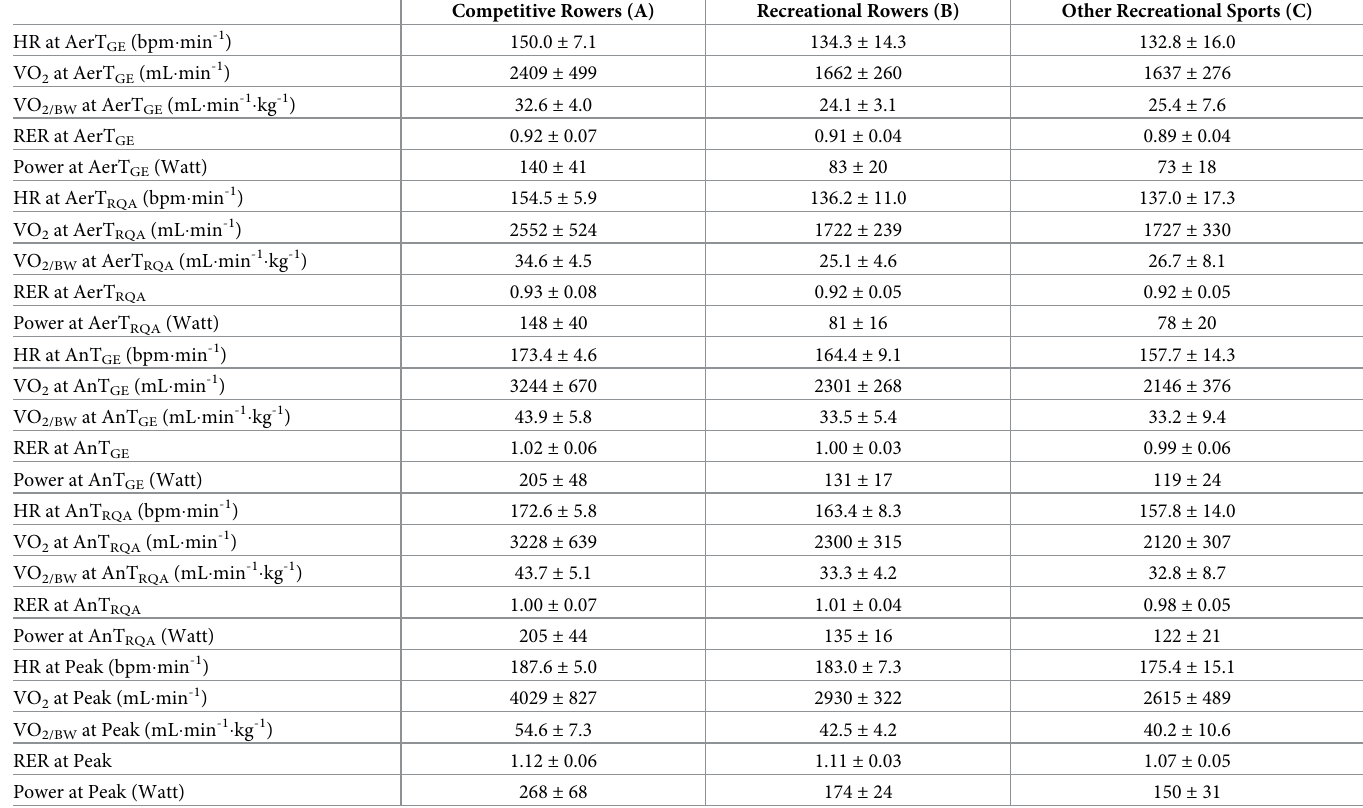
Table 2. Main parameters for group (Mean value ±